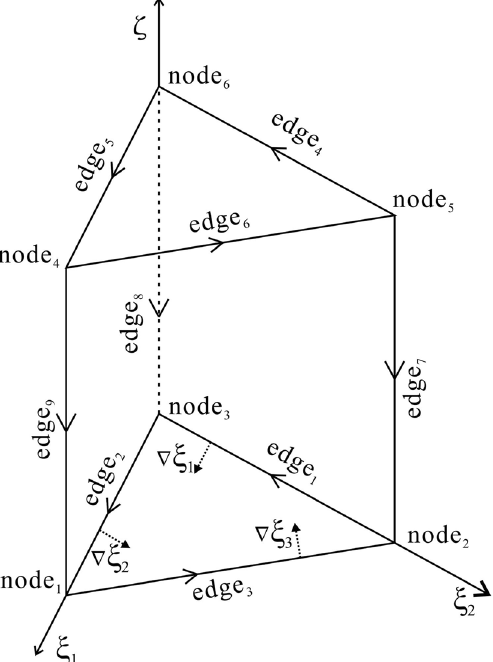
Figure 2. Illustration of one triangular prism element. There are six nodes and nine edges in the element, and the serial numbers of nodes and edges are defined in the coordinate system ( ξ 1 , ξ 2 , ξ